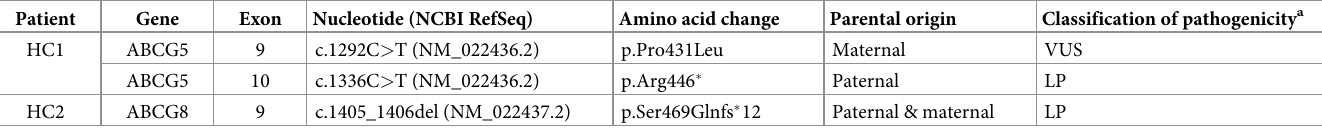
Table 5. Pathogenic variants in two overtly hypersitosterolemic